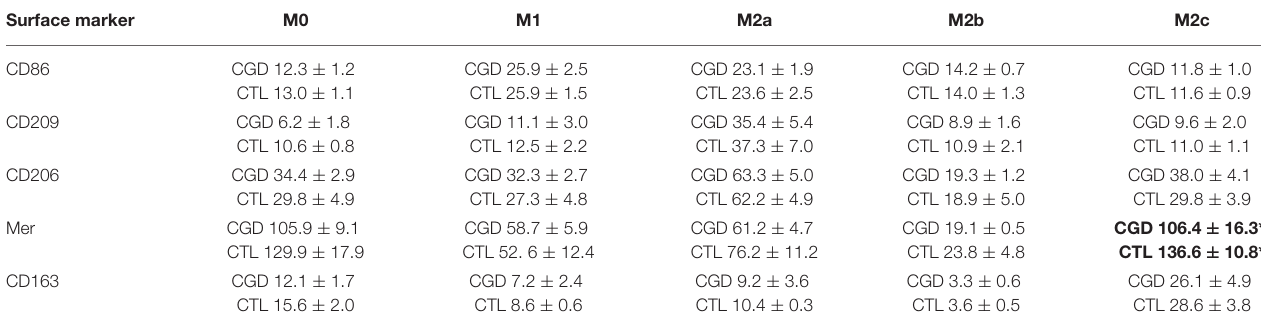
FIGURE 2 | Detection of IL-18 and IFN- γ in inflamed lymph node tissue of a CGD patient at 6 weeks of inflammation. (A) Merged DAPI (blue), IL-18 (green)/CD68 (red) double immunofluorescence staining. IL-18 signal (FITC, Alexa488) colocalized with CD68 (Cy3) on tissue macrophages. Single stainings are in Figure S1 . (B) Immunohistochemical detection of IFN- γ . TABLE 1 | Surface marker presentation of CGD macrophages compared to control upon ex vivo priming for